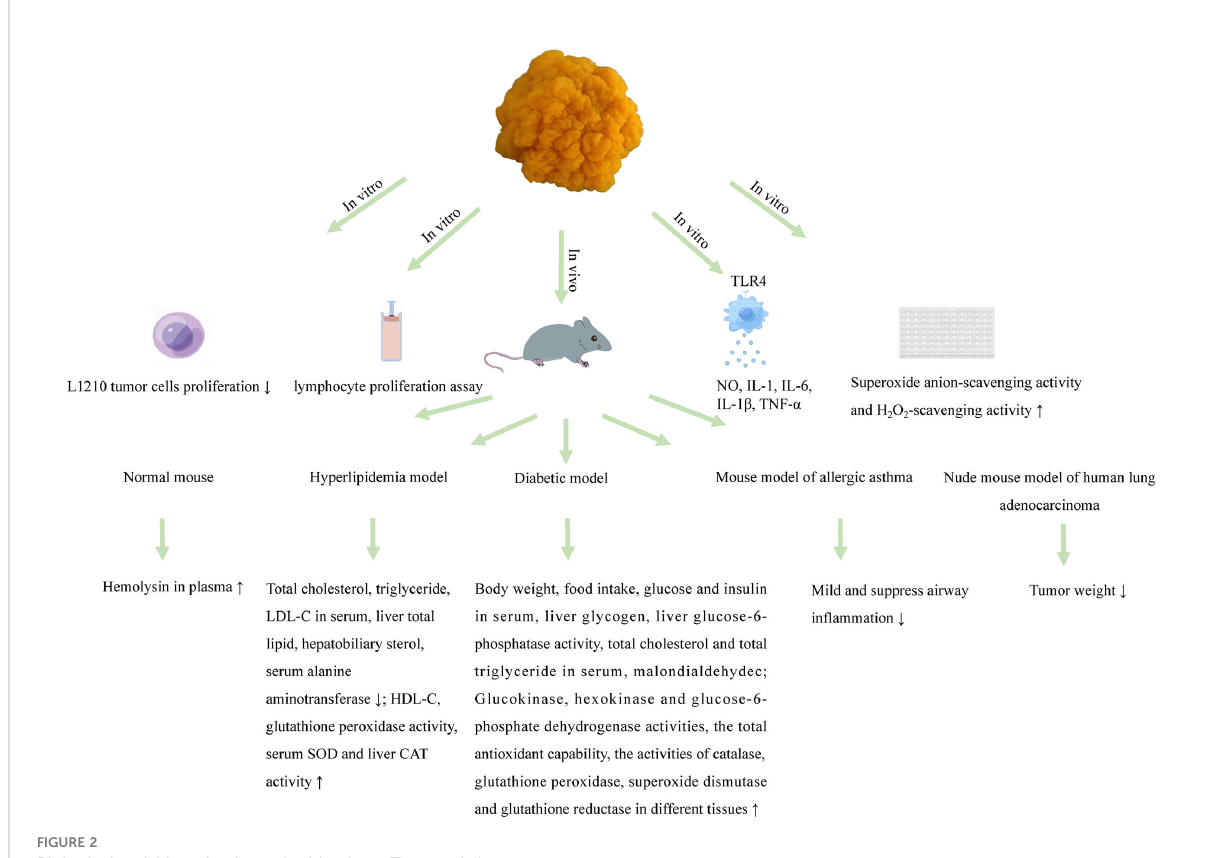
FIGURE 2 Biological activities of polysaccharides from T. aurantialba